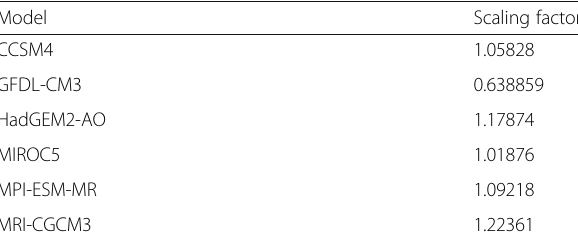
Table 1 Scaling factors for future SST trend patterns obtained from CMIP5 RCP8.5 runs by six models